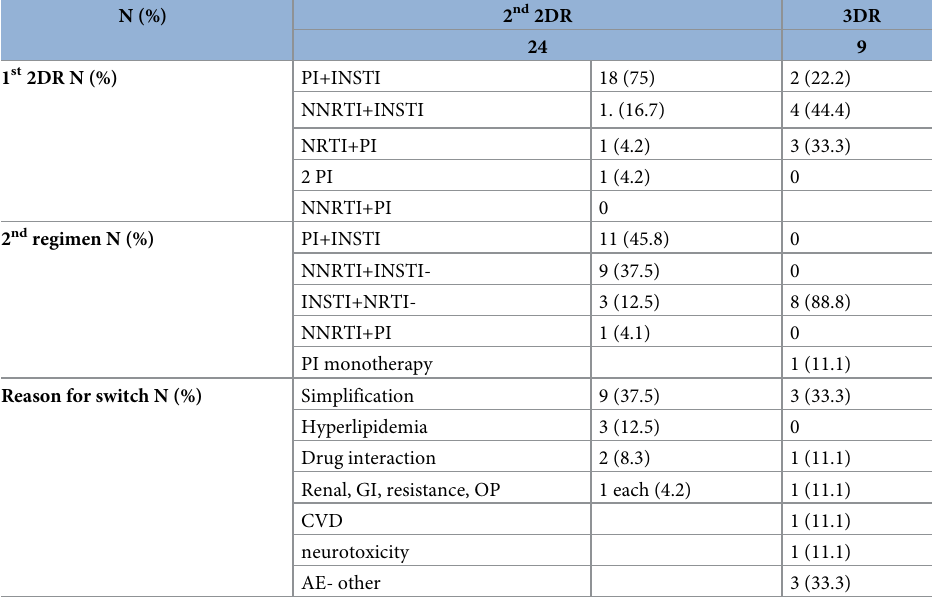
Table 3. Switch to second 2DR or 3DR.